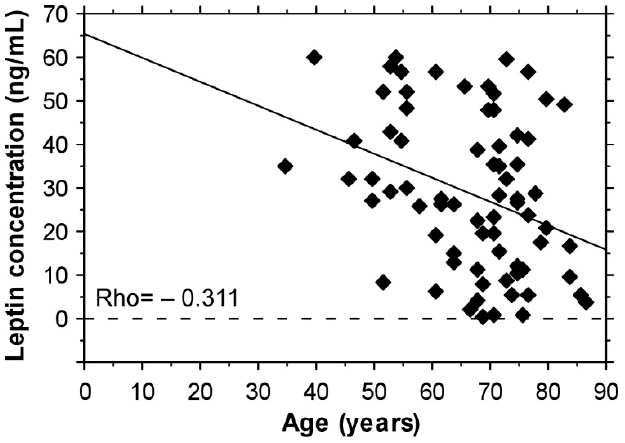
Figure 4. A tendency of decrease in serum leptin levels with aging.